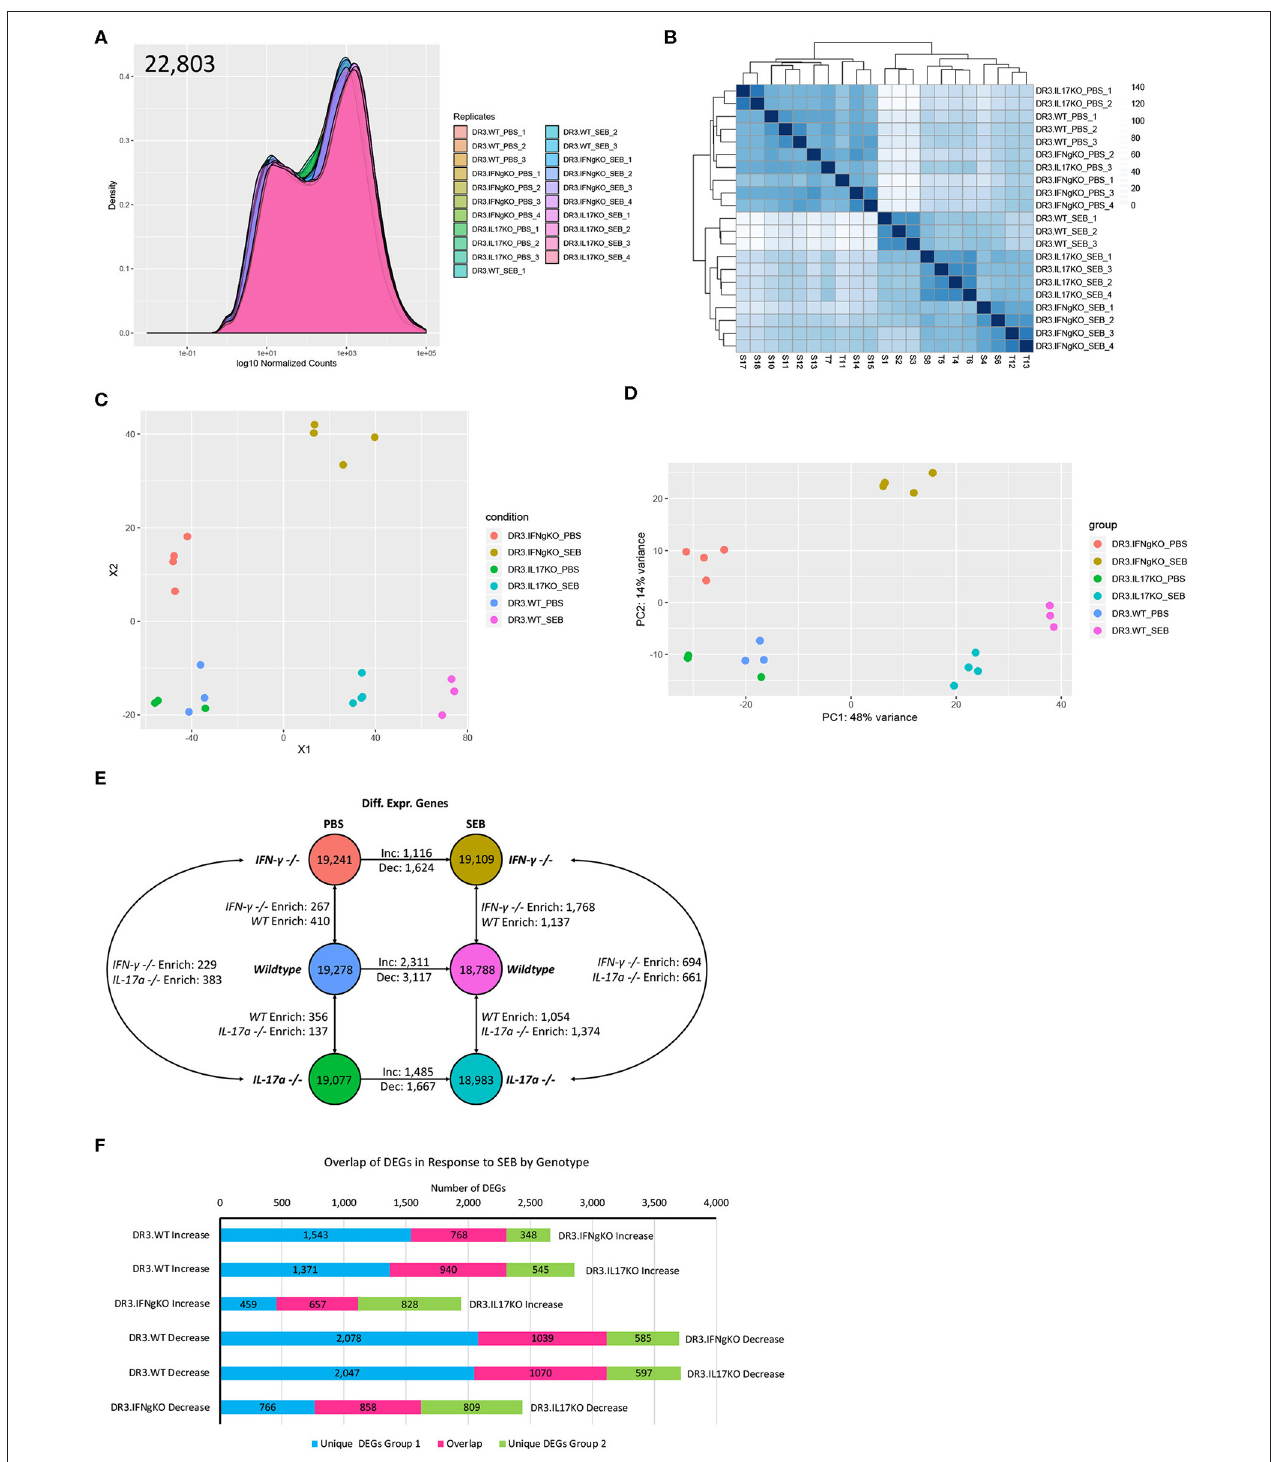
FIGURE 4 | Analysis of global gene expression and differential expression in response to SAg-induced CRS. Genes with an expression value below 10 across all sample replicates were first excluded. (A) The distribution of gene expression across all sample replicates was determined for the filtered gene set. (B) Hierarchical clustering of samples based upon global filtered gene expression. (C) Multi-dimensional scaling and (D) principal coordinate analysis (PCoA) of global gene expression for each sample replicate. (E) Differential gene expression analysis for each experimental group. (F) Comparison of differentially expressed genes in response to SEB between genotypes. “Increase” indicates genes considered to be differentially expressed in an increasing manner (log 2 fold 1 > 1, p adj < 0.05) in response to SEB. “Negative” indicates genes considered to be differentially expressed in a decreasing manner in response to SEB (log 2 fold 1 > 1, p adj < 0.05).